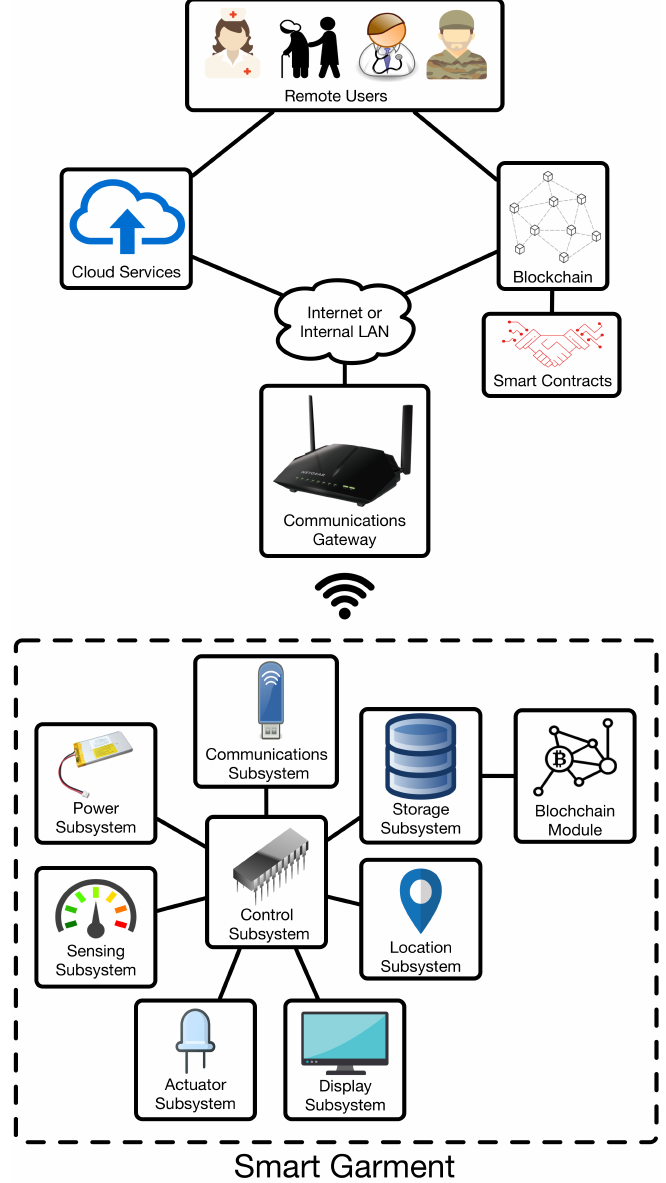
Figure 3. Generic architecture of an IoT smart garment